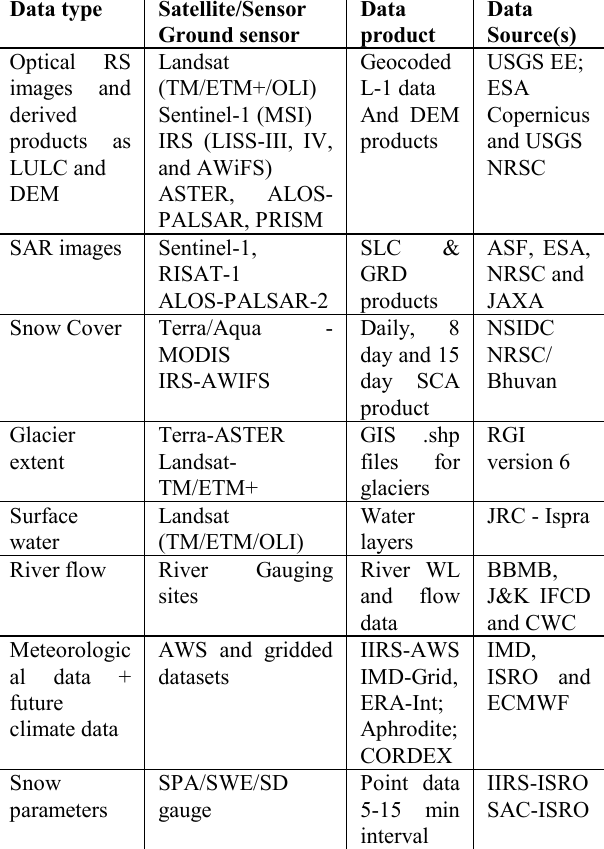
Table 1. List of various datasets along with its